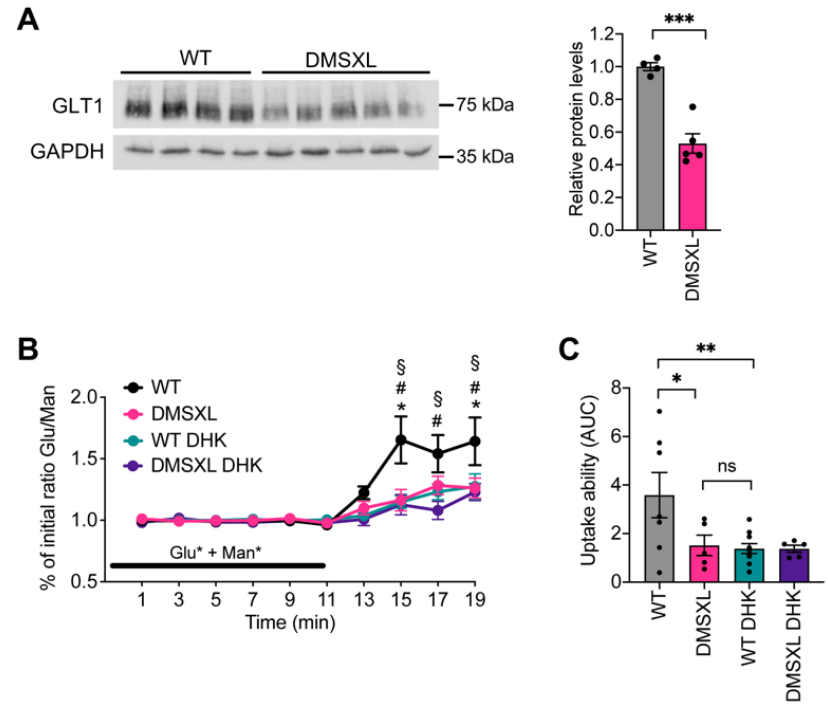
Figure 1. Glutamate uptake in mouse hippocampus. ( A ) Western blot quantification of GLT1 protein levels in the hippocampus of DMSXL and WT mice at 1 month of age. GAPDH was used as loading control. *** p < 0.001. ( B ) The in vivo ability of glutamate uptake in the dorsal hippocampus was monitored in mice aged 2–3 months by comparing the ratio of L-[ 3 H]-glutamate/[ 14 C]-mannitol radioactivity in the presence (DMSXL, n = 5; WT, n = 10) or absence (DMSXL, n = 5; WT, n = 7) of 2 mmol/L DHK. Ratios were normalized to the initial isotopic solution infused through the microdialysis probe. * p < 0.01, DMSXL vs. WT; # p < 0.05, WT DHK vs. WT; § p < 0.01, DMSXL DHK vs. WT. Glu, glutamate. Man, mannose. ( C ) Estimation of glutamate uptake ability using AUC during the wash-out. * p < 0.05, ** p <